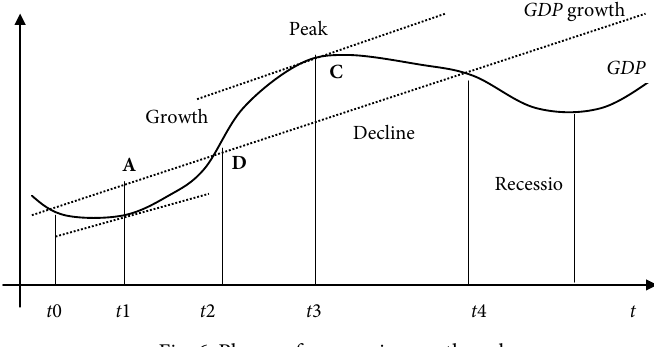
Fig. 6. Phases of economic growth